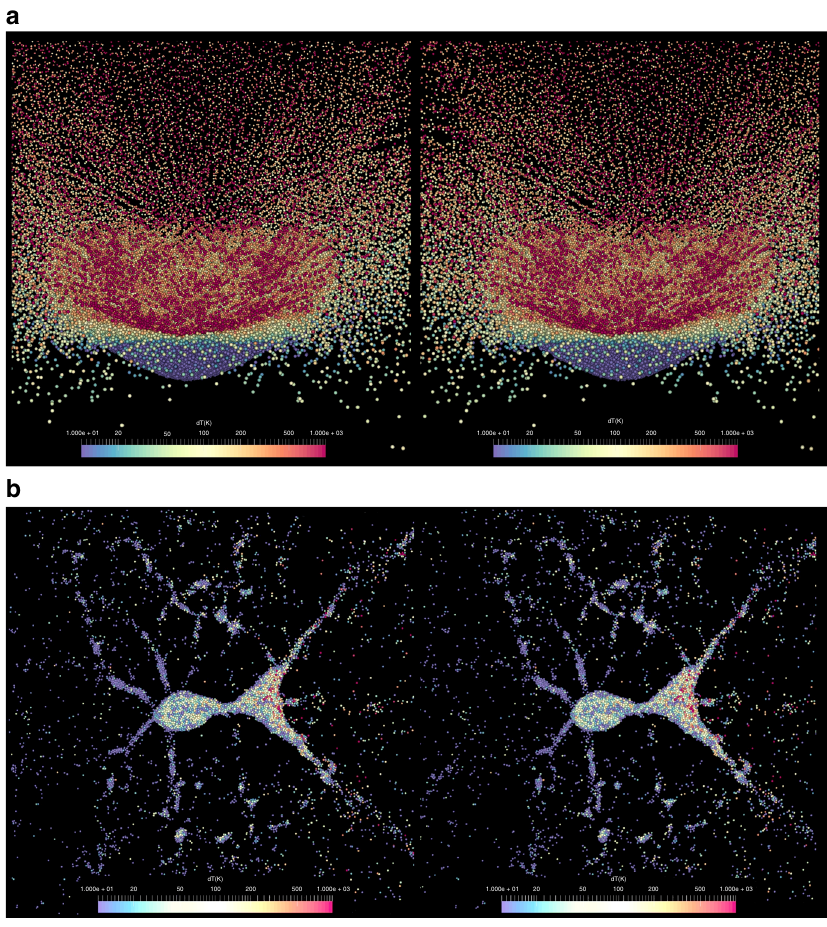
Fig. 3 A catastrophic disruption can be at the origin of thermal alteration. a Stereoscopic pair at time t = 0 of the gravitational phase of the disruption of the parent body for simulation 3 (see Supplementary Movie 1). The peak temperature change for each particle from the impact is shown (see also Fig. 5) with colors scaling from 10 K (blue) to 1000 K (red). b Stereoscopic pair of the gravitational reaccumulation of the largest remnant (see Supplementary Movie 2) at t = 4.75 hours, exhibiting fi lamentary structure that will eventually collapse into a single aggregate. Other smaller fi laments will escape and collapse to form smaller aggregates. This stereoscopic pairs in the Supplementary Movies can be viewed in ‘ parallel ’ stereo mode simply by relaxing the eye convergence. We suggest to view the pair of images from a foot or so away, and look through the screen to in fi nity, allowing the two images to fl oat across each other. Where the two central pictures exactly overlap, the ‘ fused ’ 3-D image is to be found; all that is then necessary is to gently adjust the focus of the eyes, while the convergence remains relaxed, to obtain a clear stereoscopic image. This technique is called ‘ Free Viewing ’ of stereo pairs. For a more authentic stereo effect, use a Brewster format stereoscope — The London Stereoscopic Company OWL or similar. Detailed instructions may be found at